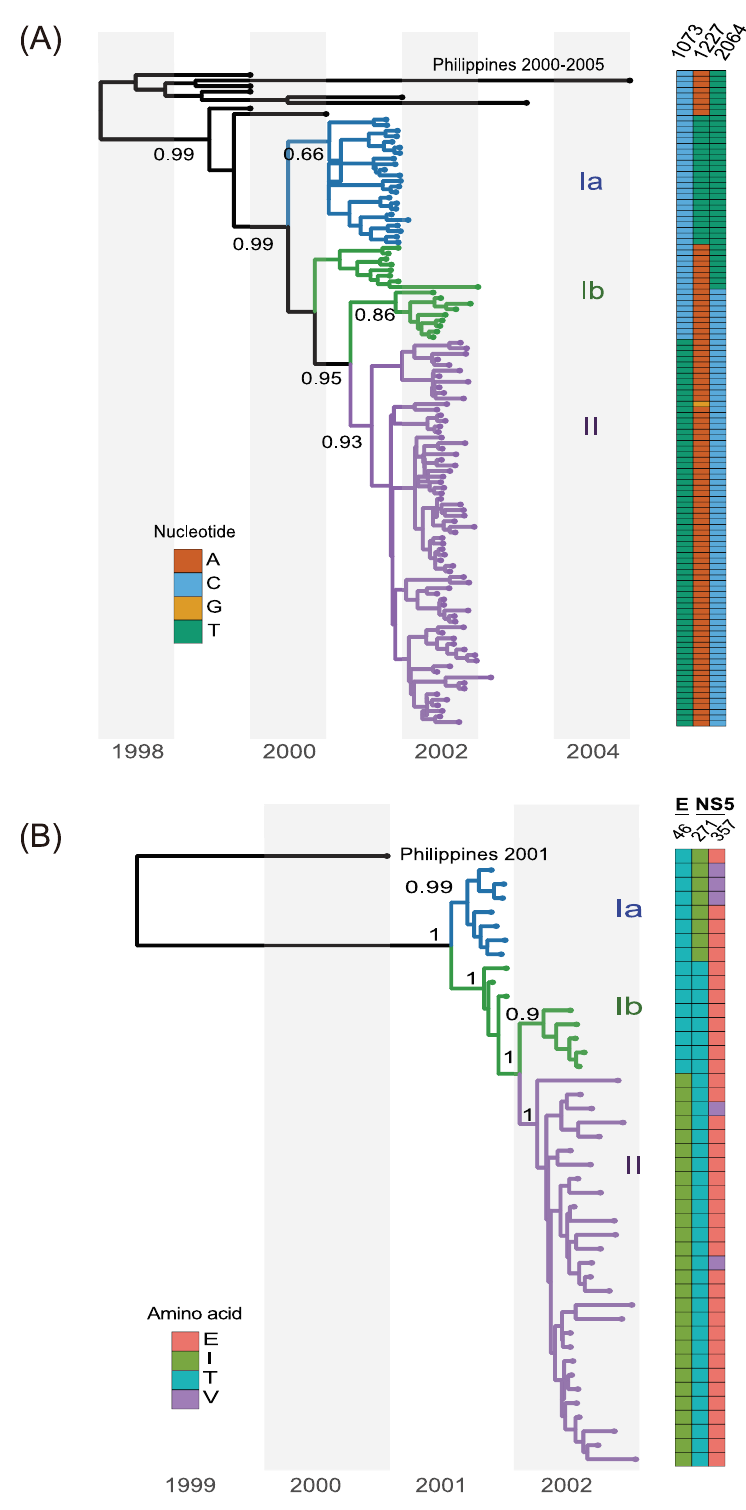
Fig 2. Maximum clade credibility (MCC) tree of the E and ORF genes. (A) A MCC tree based on the E genes of 104 DENV-2 viruses isolated during 2001–2003 in southern Taiwan together with those from the Philippines as a